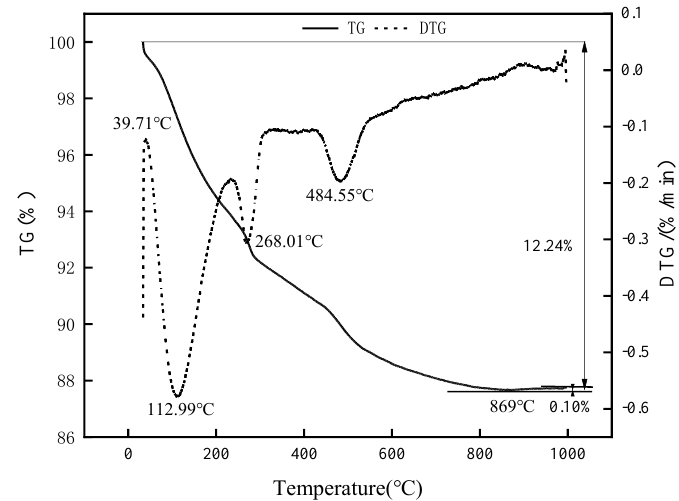
Figure 5. Thermal analysis of the polyaluminum chloride slag.